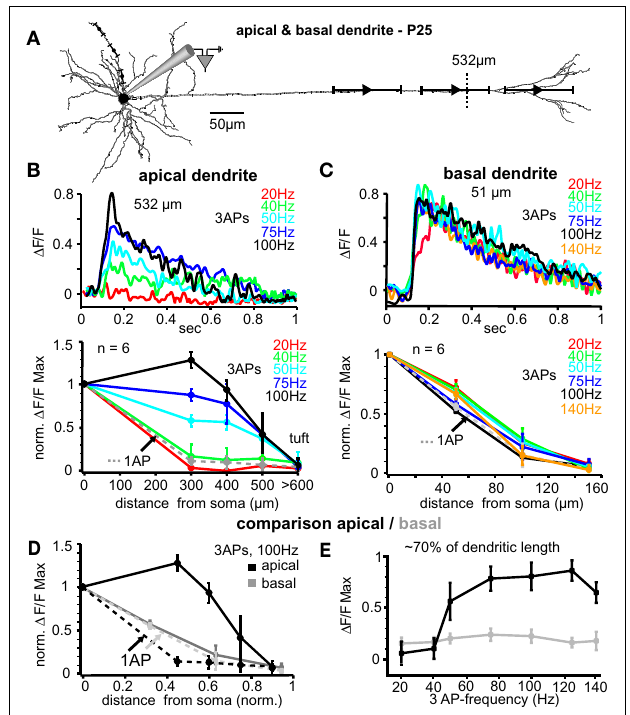
FIGURE 3 | Critical frequency for back-propagation of short AP trains in apical but not basal dendrites. (A) Reconstruction of a L5A pyramidal neuron at P25. Ca 2 + measurements were taken at the soma and at three different distances along either the apical dendrite or the basal dendrite (indicated by the symbols and ranges). (B) Apical dendrites, upper panel . Ca 2 + transients ( Δ F/F) evoked by trains of three APs at different fi xed frequencies measured at the main apical dendrite 532 µm from soma (see dashed line in A ) in a P25 L5A pyramidal neuron. Lower panel . Normalized amplitudes of Ca 2 + transients evoked by single APs (dashed line) and trains of APs at different frequencies are plotted as function of distance from soma. Average values are mean ± sem ( n = 6). (C) Basal dendrites, upper panel . Ca 2 + transients ( Δ F/F) evoked by trains of three APs at different fi xed frequencies measured in the basal dendrite 51 µm from soma in a P25 L5A pyramidal neuron. Lower panel . Peak Δ F/F Ca 2 + signals evoked by single APs and AP trains at different frequencies are normalized and plotted against distance from soma (mean ± sem, n = 6). Comparison between apical and basal dendrites. (D) Peak Ca 2 + signals elicited by single APs and trains of three APs at 100 Hz were normalized and plotted as function of distance for apical and basal dendrites. Distances were normalized with respect to the total length of these dendrites . (E) Ca 2 + transients ( Δ F/F max) evoked by three APs are plotted as function of frequency at 70% of the total basal and apical dendritic length. All data are from P25 neurons.